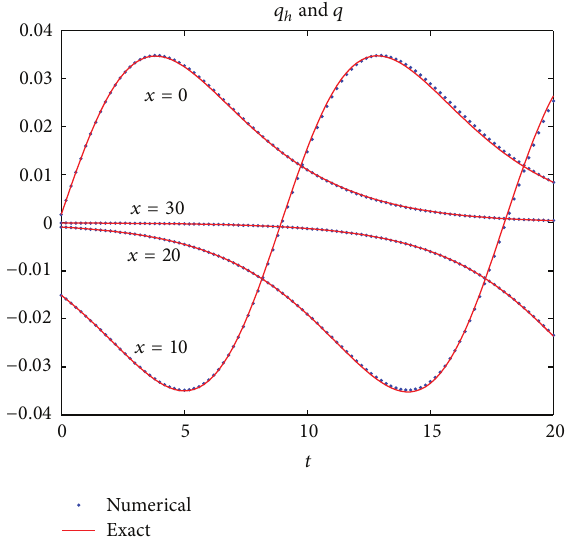
Figure 8: Comparison between 𝑞 and 𝑞 ℎ at spaces 𝑥 = 0 , 10 , 20 , and 30 with ℎ = 0.125 and Δ𝑡 = 0.2